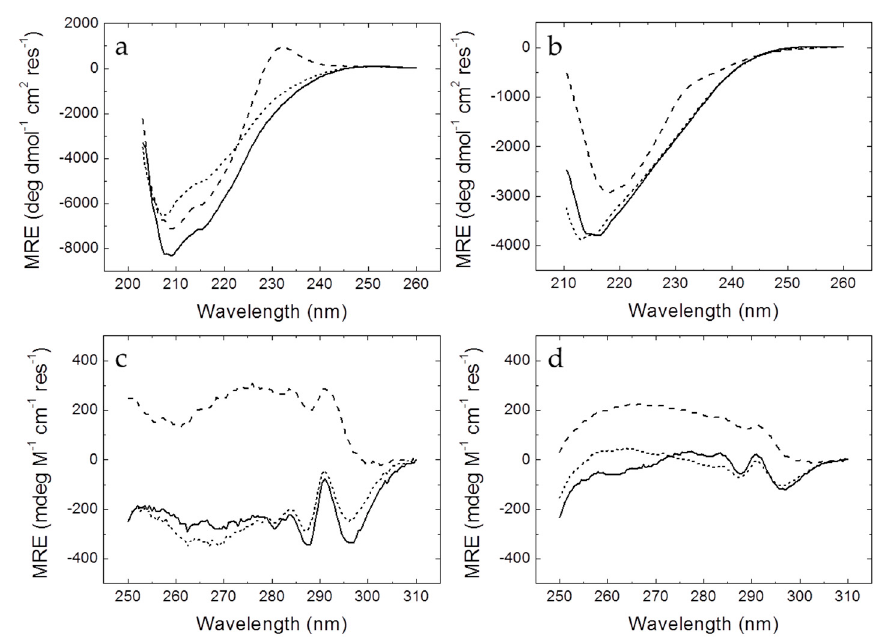
Figure 1. Far-UV ( a , b ) and near-UV ( c , d ) circular dichroism spectra of wild-type and mutant Methyl-CpG binding protein 2 (MeCP2) methyl-CpG binding domain (MBD) ( a , c ) and NTD-MBD-ID ( b , d ): wild-type (continuous line), R106W (dashed line), and R133C (dotted line). Spectra were recorded at pH 7.